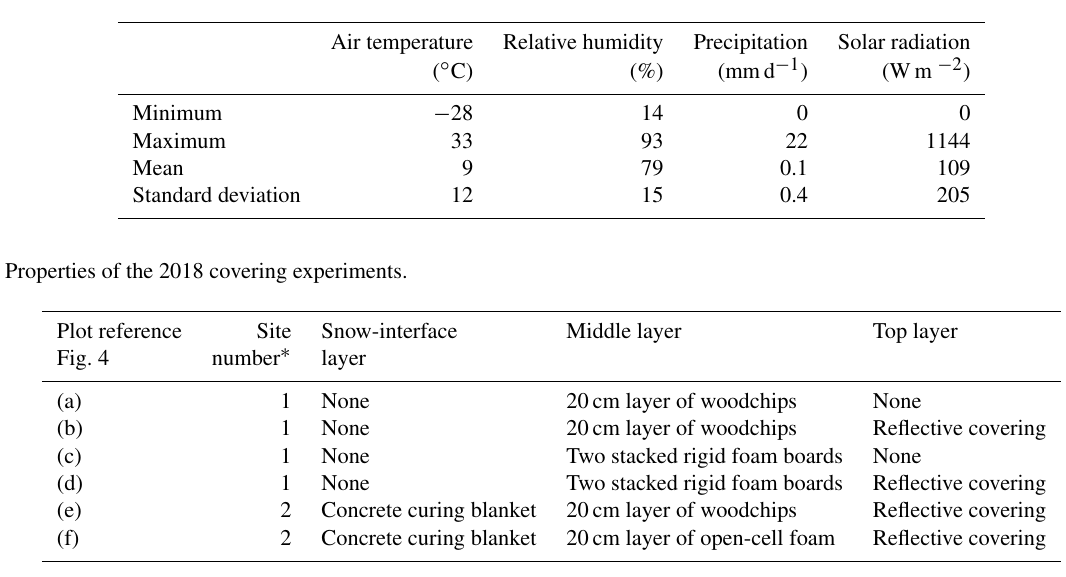
Table 1. Weather parameters measured between June 2017 and October 2018 at the Craftsbury Outdoor Center, Craftsbury, VT.